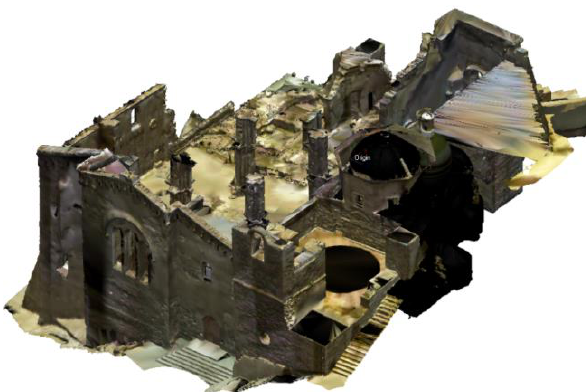
Figure 12. Textured digital bulding